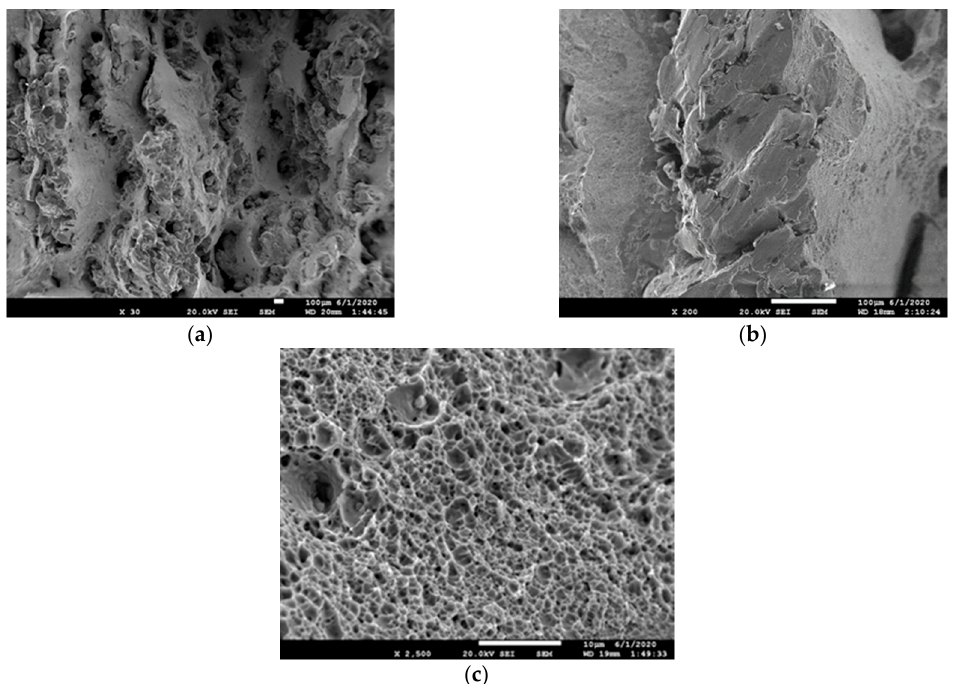
Figure 9. The fractured surface of the hexagonal family 1 (samples 19–21) with ( a ) step-like structure with fracture in the fusion zones between different build layers, ( b ) brittle propagation region along a step, and ( c ) ductile fracture in the build layer.